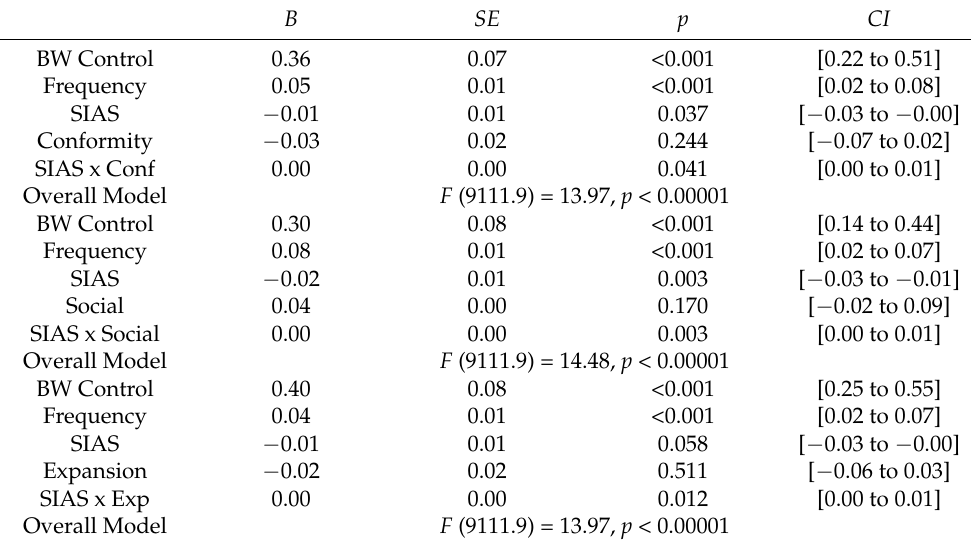
Table 2. Regression of behavioral willingness for cannabis on social anxiety, cannabis use motives, and interaction terms in the card game scene (2 actors) when interactions were statistically significant ( N = 124). B SE p CI BW Control 0.36 <0.001 [0.22 to 0.51] 0.01 <0.001